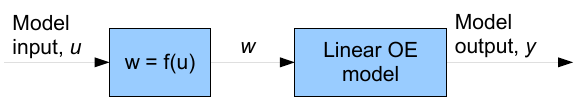
Figure 14: Block diagram of the final Hammerstein